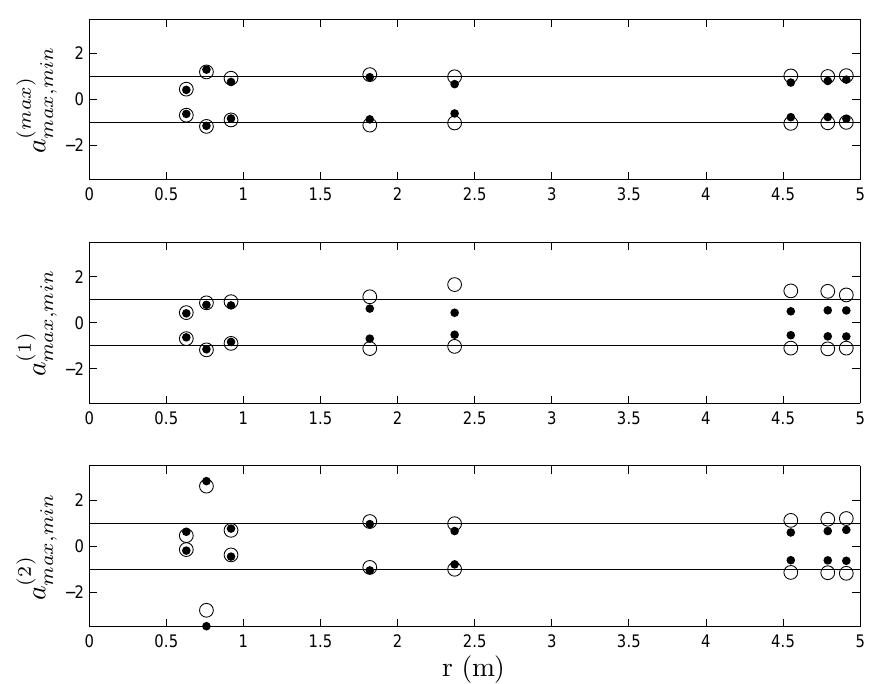
Fig. 6. Positive and negative maximum free water surface elevations values for the maximum (top panel), the first (middle panel) and the second wave (bottom panel) encountered at all the sea level gauges. The circles refer to the values obtained with the proposed model, the dots to the one solved using the source term proposed by Tinti et al. (2006); in both cases the values are normalized with the experimental measurements. The same simulations results are now represented in Fig. 6, in terms of the positive and negative